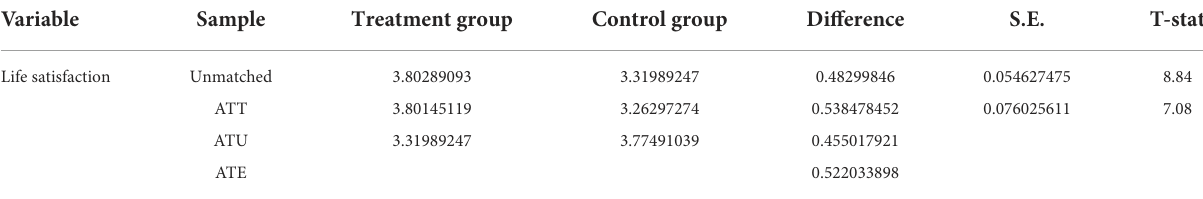
TABLE 10 Results of PSM treatment.